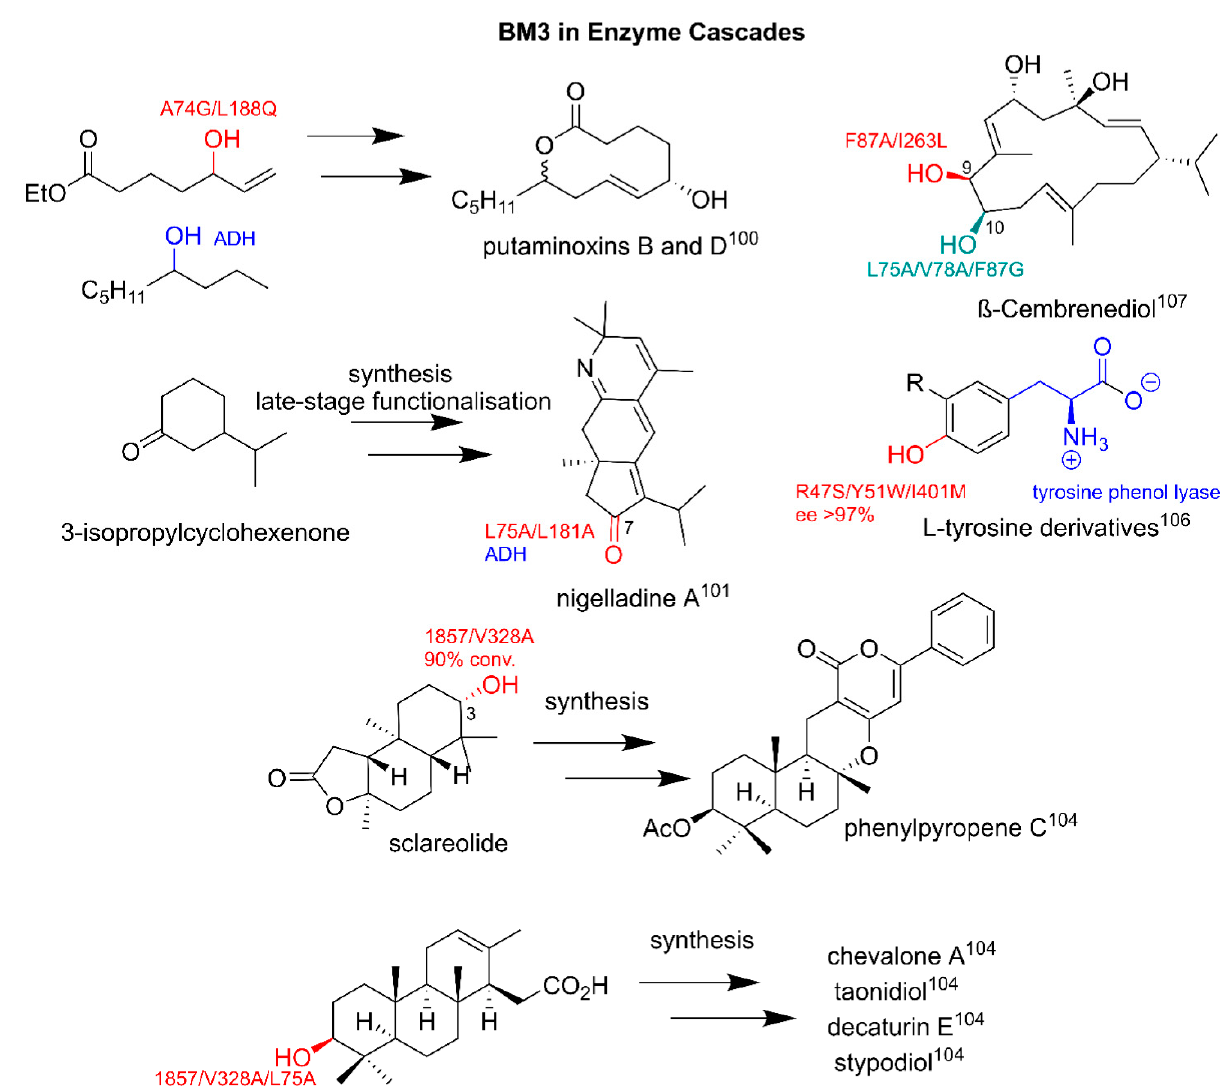
Figure 6. BM3 in enzyme cascades. Parent compounds are in black. BM3-related modifications are in red and green. Other enzymes are in blue. Conv, conversion; sel, selectivity; ee, enantiomeric excess. Literature references are in superscript.